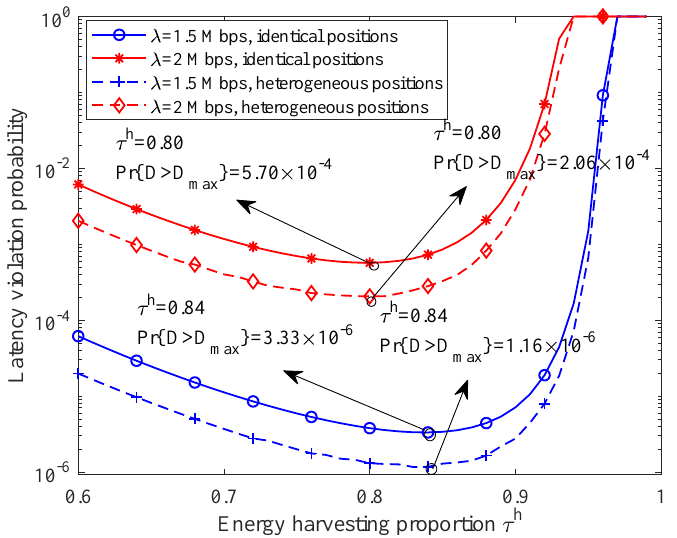
Figure 6. The relationship between network LVP and energy harvesting proportion under different positions of